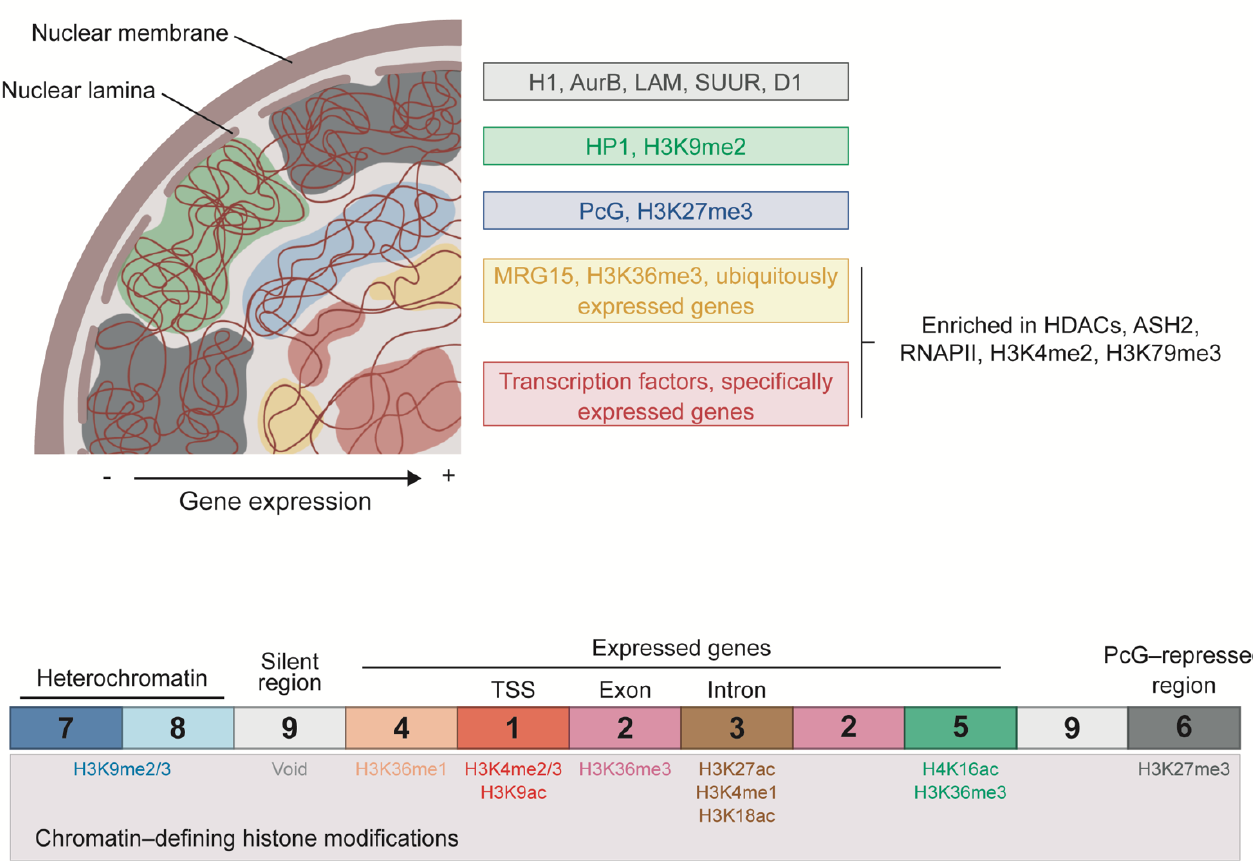
Figure 1. Classification of the chromatin landscape in Drosophila . ( A ) Chromatin segmentation into 5 types according to combinatorial protein binding. BLACK, GREEN, and BLUE chromatin types correspond to repressed and silenced domains, whereas YELLOW and RED chromatin types represent active regions. The more repressed regions tend to localize at the periphery of the nucleus, with BLACK and GREEN chromatin interacting with the nuclear lamina. Only the most characteristic components of each chromatin type are indicated. Based on Filion et al. [13]. ( B ) Division of chromatin into 9 states attending to histone modification patterns. States 1, 2, and 5 are associated with actively transcribed genes; states 3 and 4 with putative regulatory regions; state 6 with PcG-repressed regions; states 7 and 8 with heterochromatin; and state 9 corresponds to silent regions. The most enriched histone modifications are indicated for each chromatin state. Based on Karchkenko et al. [92].